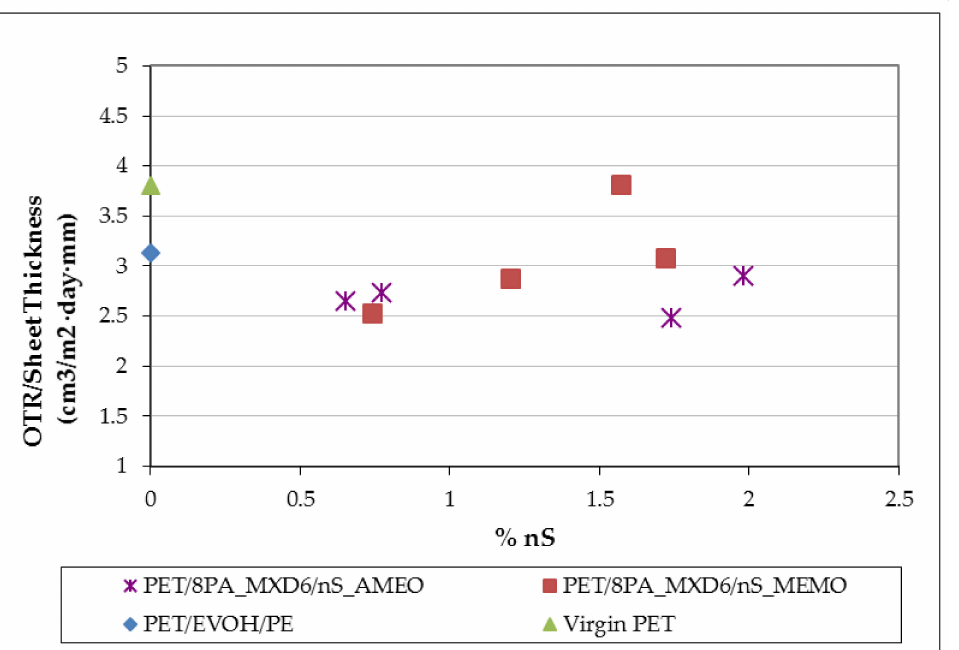
Figure 7. Oxygen permeability of nanocomposites.